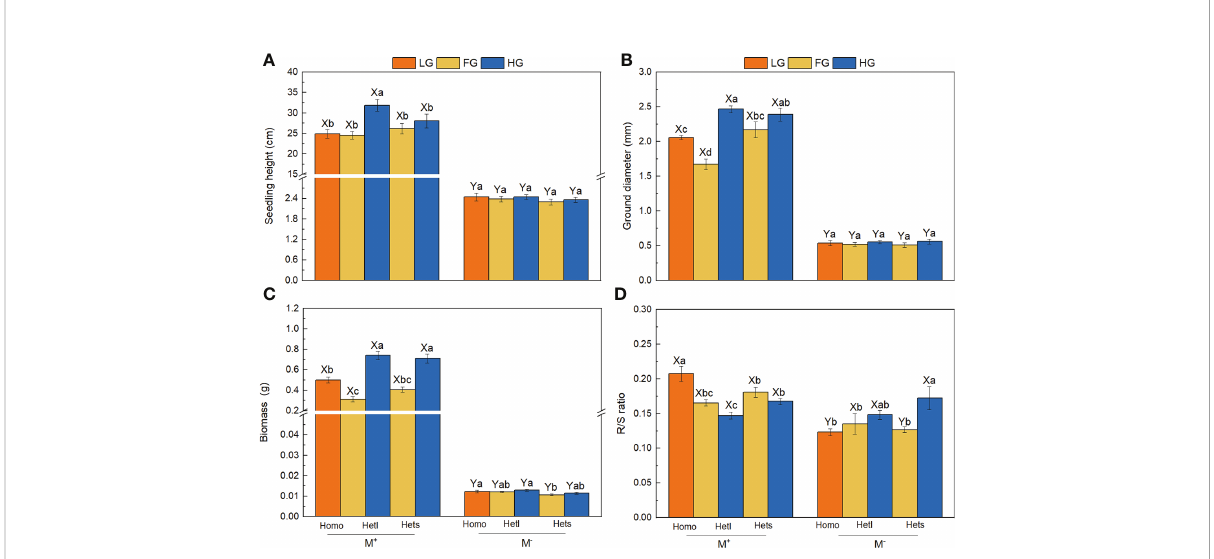
FIGURE 2 The seedling height, ground diameter, biomass and R/S ratio of B pilosa . For the seedling height (A) , ground diameter (B) , biomass (C) , and R/S ratio (D) of B. pilosa, M + = with AMF; M – = without AMF; Homo = homogeneous patch; Hetl = heterogeneous large patch; Hets = heterogeneous small patch. LG = low gravel substrate; FG = free gravel substrate; HG = high gravel substrate. Different capital letters (X, Y) above the bars indicate signi fi cant differences between M + and M - treatments; different lowercase letters (a – d) above the bars indicate signi fi cant differences among various heterogeneous treatments ( P <